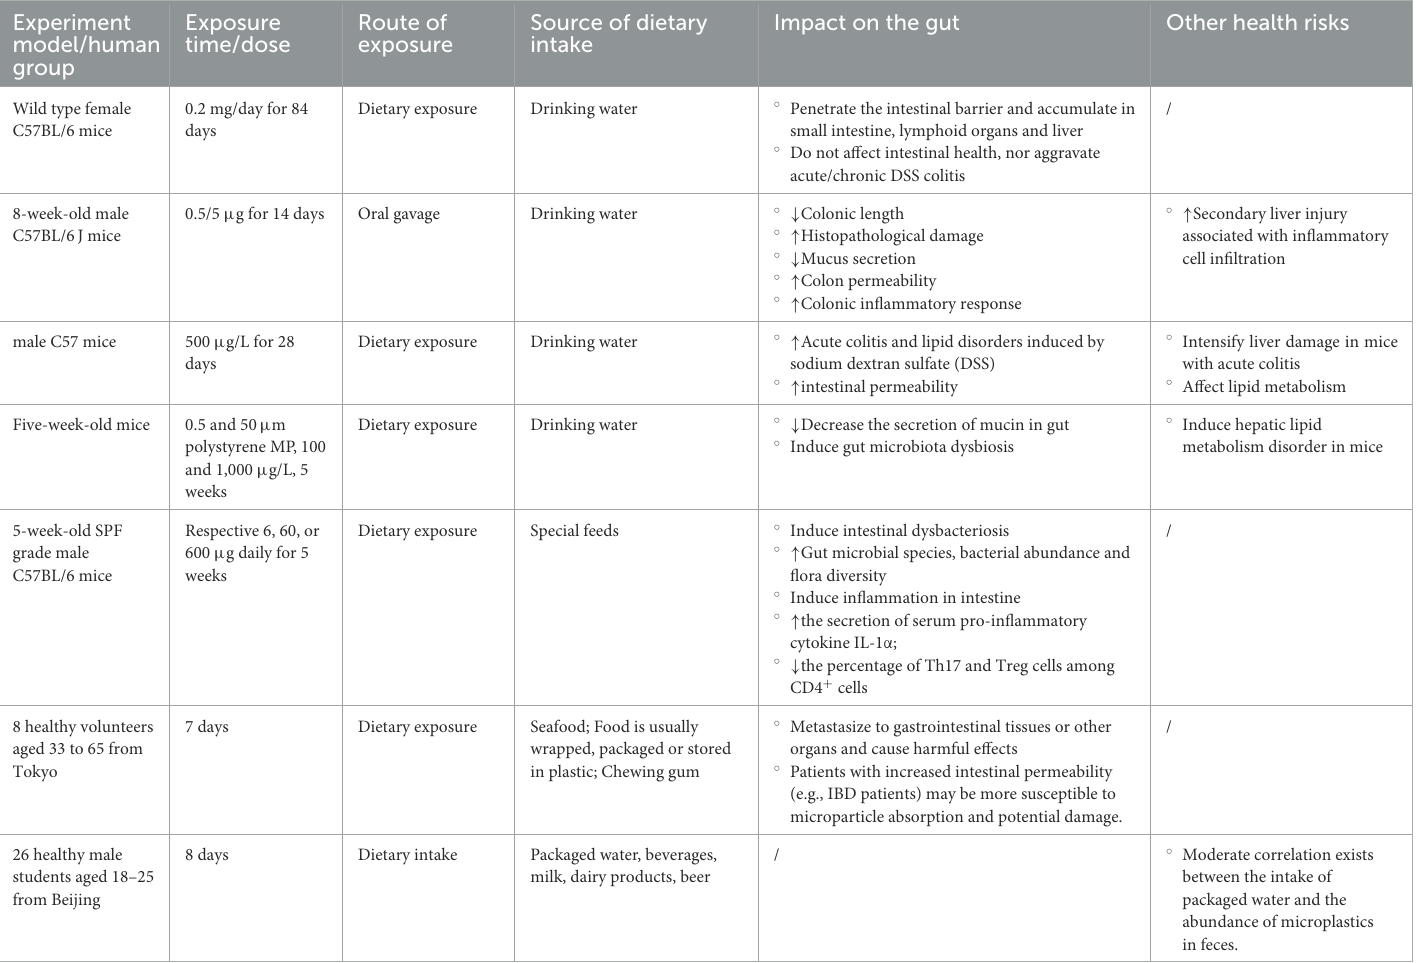
TABLE 1 Adverse health effects of microplastics in inflammatory bowel